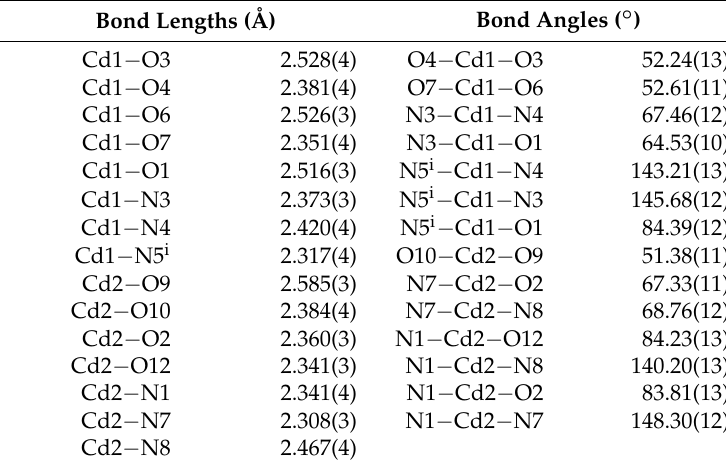
Table 2. Selected bonding parameters for 1